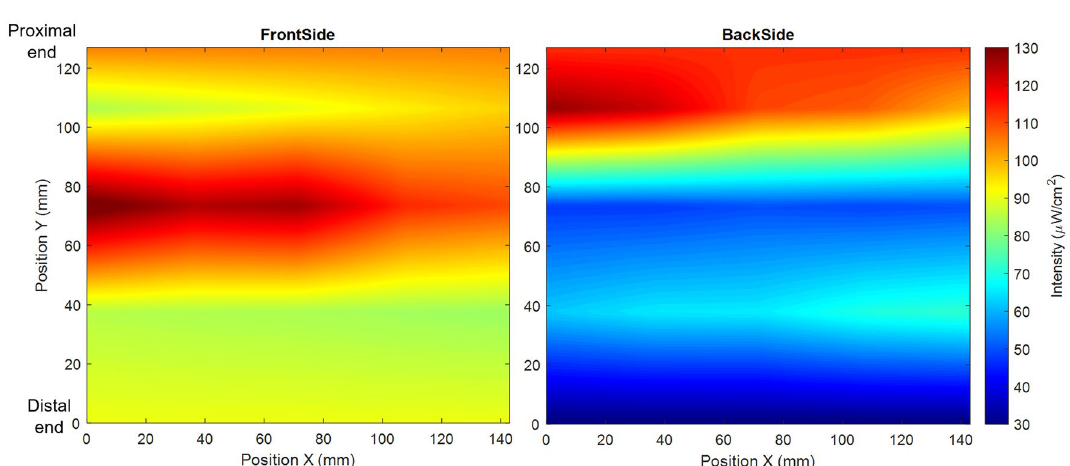
Figure 4. Contour plots of UVC intensity across front and back sides of the face covering. The “front” side faces the wearer’s environment, while the “back” side is in contact with the wearer’s nose and mouth. Areas of highest light intensity are shown in red, while areas of lower light intensity are shown in blue. The “proximal end” of the face covering refers to the top of the mask that sits on the bridge of the nose, and the “distal end” of the face covering refers to the bottom of the mask that is in contact with the neck